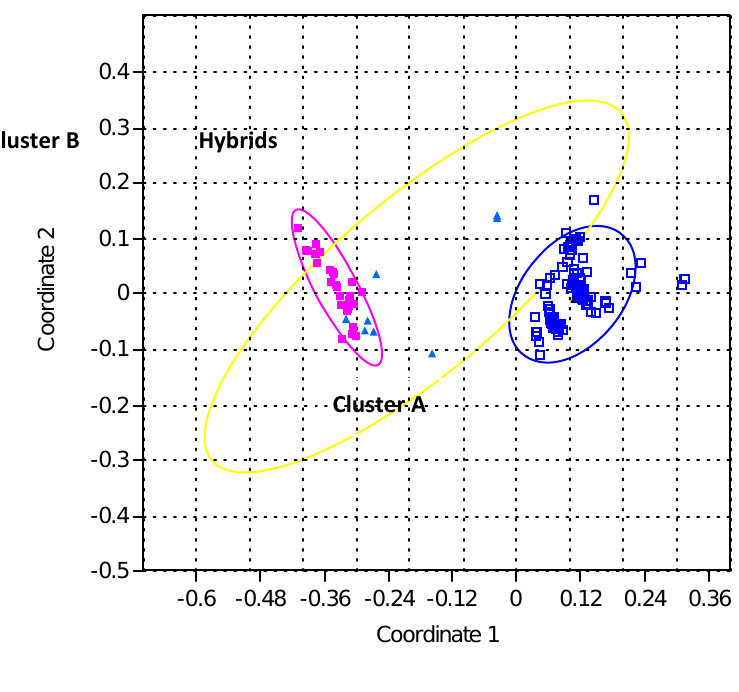
Figure 4: The scatter plot from the Principal Coordinate Analysis (PCoA) of morphological characters for the pure populations of tentative parents and hybrids of Nymphaea .